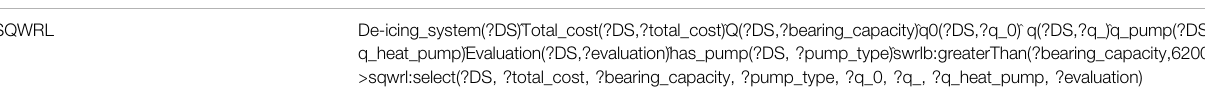
TABLE 9 | SQWRL rules to query bearing capacity greater than 62,000 kN. SQWRL